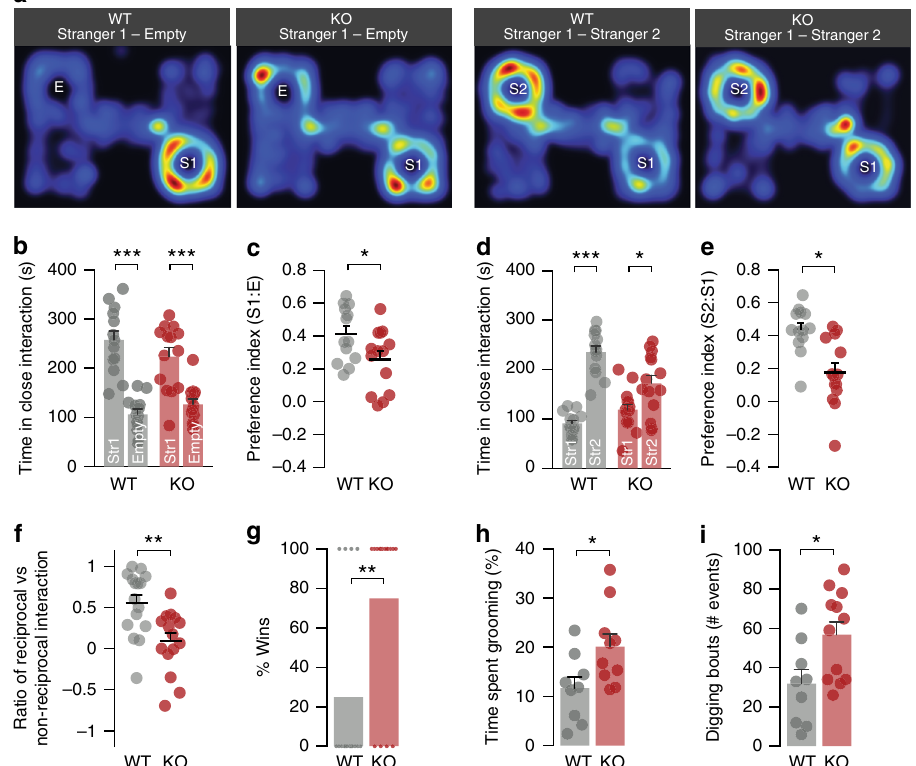
Fig. 8 Gprasp2 − /y mice display social and ASD-like behavioural alterations. a Representative heat map images from ‘ Stranger1 – Empty ’ and ‘ Stranger1 – Stranger2 ’ from three-chamber social test trials for Gprasp2 − / y mice and littermate controls. b , c Gprasp2 − /y interact with ‘ Stranger ’ stimulus mice ( b ), but display reduced preference for social interaction when comparing with WT mice ( c ); WT n = 13; KO n = 14; two-tailed t -test. d , e Gprasp2 − /y display reduced total time interacting with social partners ( c ) and reduced preference index for ’ Stranger2 ’ ( e ) when comparing to WT controls; WT n = 13; KO n = 14; two-tailed t -test. f In the social dyadic test, Gprasp2 − /y show decreased ratio of reciprocated vs non-reciprocated social interactions against C57BL6 stimulus mice; WT n = 16, KO n = 15, two-tailed t -test. g In the tube test for social dominance, Gprasp2 − /y mice displayed greater percentage of win trials against WT controls; WT n = 16, KO n = 16; chi-square test. h , i Gprasp2 − /y mice display increased stereotypical behaviours measured as time spent grooming ( h ) and frequency of digging bouts ( i ) during a 30-min session; WT n = 9, KO n = 10; two-tailed t -test for ( h ) and two-tailed Mann – Whitney test for ( i ). All data are presented as means± s.e.m. Statistical signi fi cance: * p < 0.05, ** p < 0.01 and *** p <